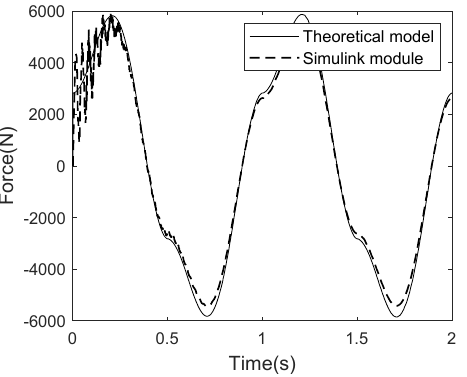
Figure 5. The comparison curve between theoretical model and pipe module in Simulink.